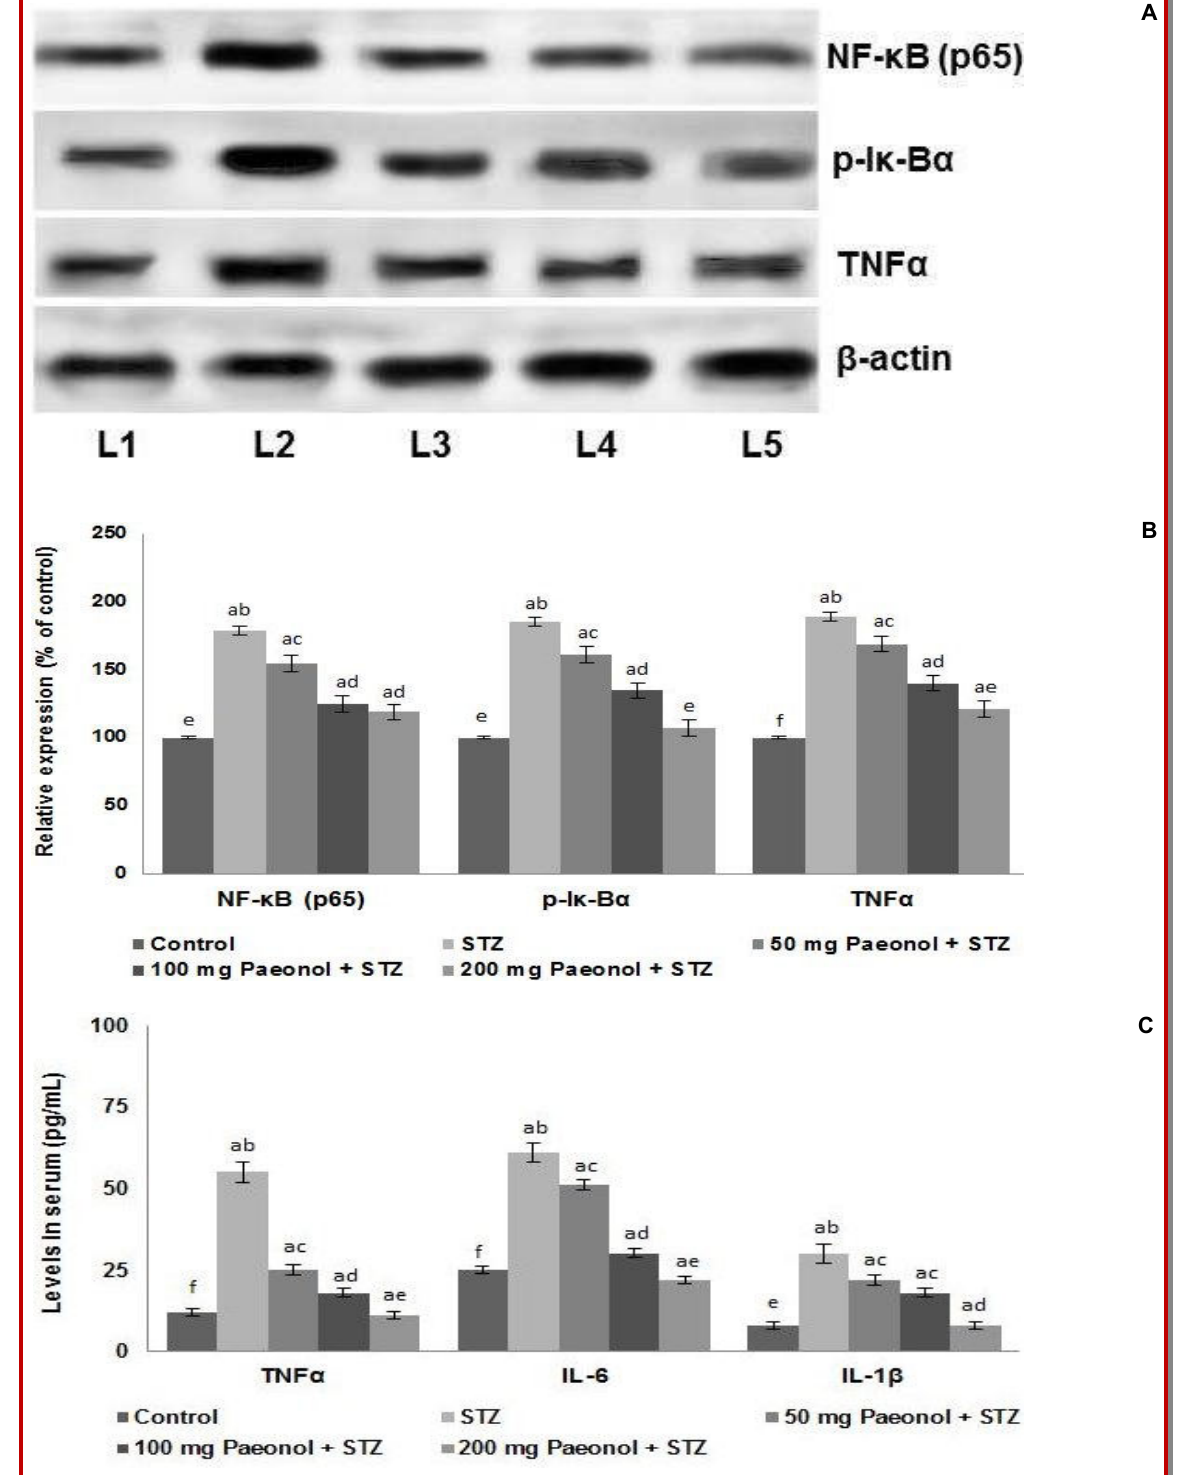
Figure 7: Antioxidant and anti-inflammatory effects of paeonol. Paeonol effectively down-regulated expressions of NF- κ Bp65 and p-I κ - B α in the cardiac tissues (A and B), reduced serum levels of inflammatory mediators (C) and decreased serum ROS levels (D) Values are represented as mean ± SD, n=6. a represents statistical significance at p<0.05 compared against respective controls and b-f represents significant difference (p<0.05) between mean values within the groups as determined by one-way ANOVA followed by DMRT analysis (L1-Control; L2-streptozotocin; L3-50 mg paeonol + streptozotocin; L4-100 mg paeonol + streptozotocin; L5-200 mg paeonol +